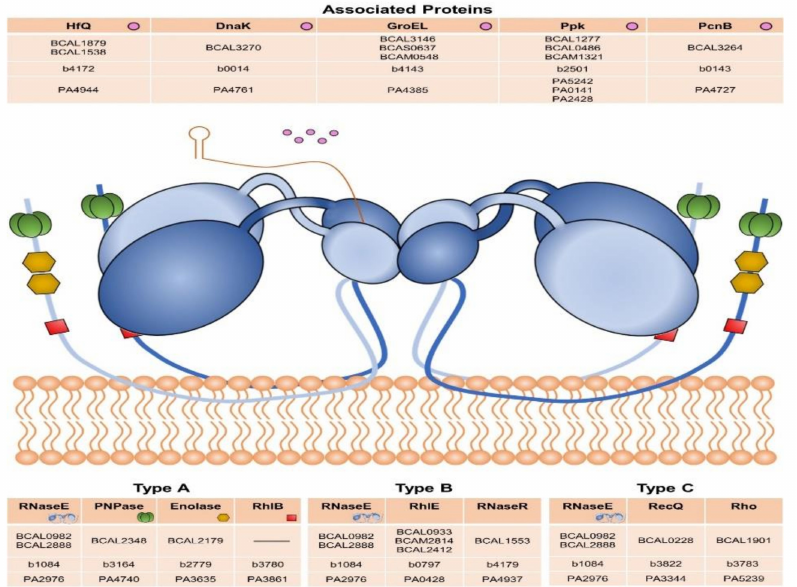
Figure 8. Schematic representation of the membrane-associated RNA degradosome. The main degradosome components were identified and the locus tag of each ortholog gene encoded in B. cenocepacia J2315, E. coli strain K-12 MG1655, and P. aeruginosa PAO1 genomes is